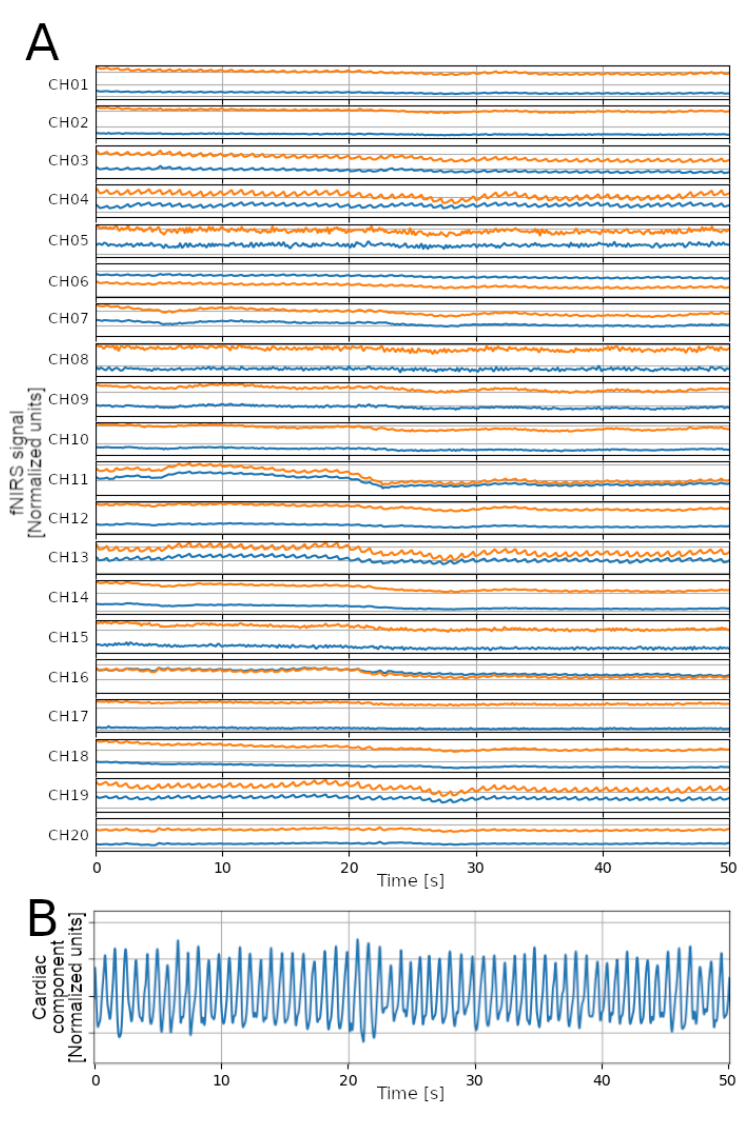
Figure 4. Extraction of the cardiac component from fNIRS data. ( A ) 50 s segment of fNIRS signals for the 20 channels (blue: 760 mn wavelength; orange: 850 nm); ( B ) the obtained signal representing the cardiac component, resulting from the band-pass filtering (0.67–8.0